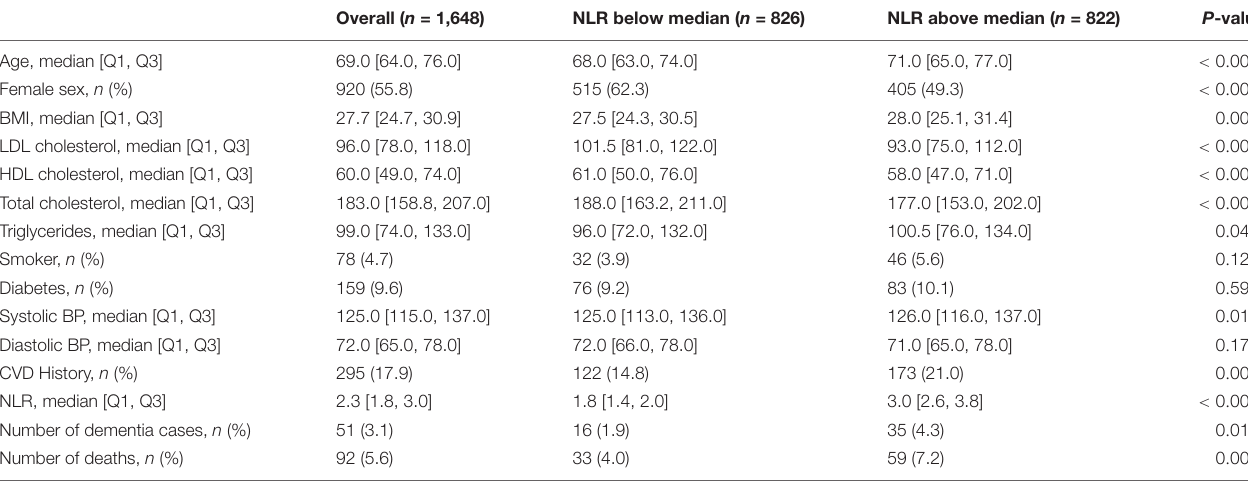
TABLE 1 | Comparison of demographic and clinical characteristics by the neutrophil to lymphocyte ratio (NLR).